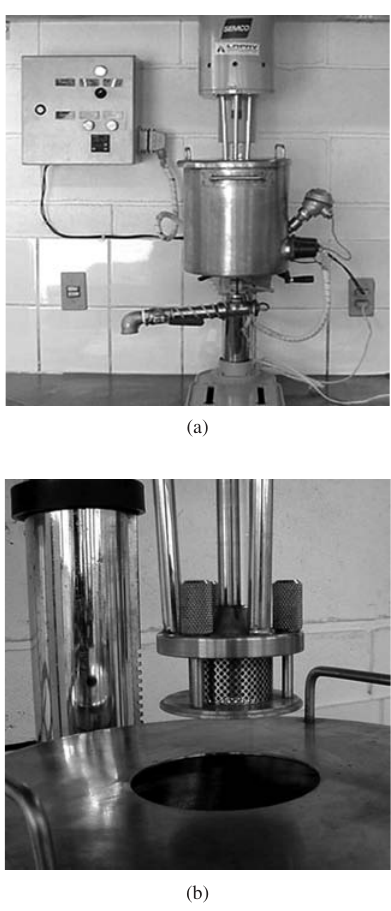
Figure 1. Device used in sample preparation.